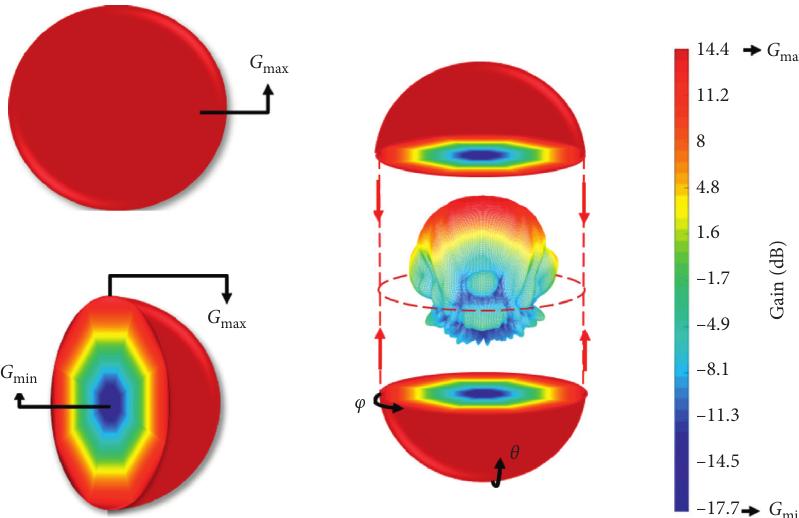
Figure 13: Coverage function methodology applied to the 17-entry codebook envelope of the PBS